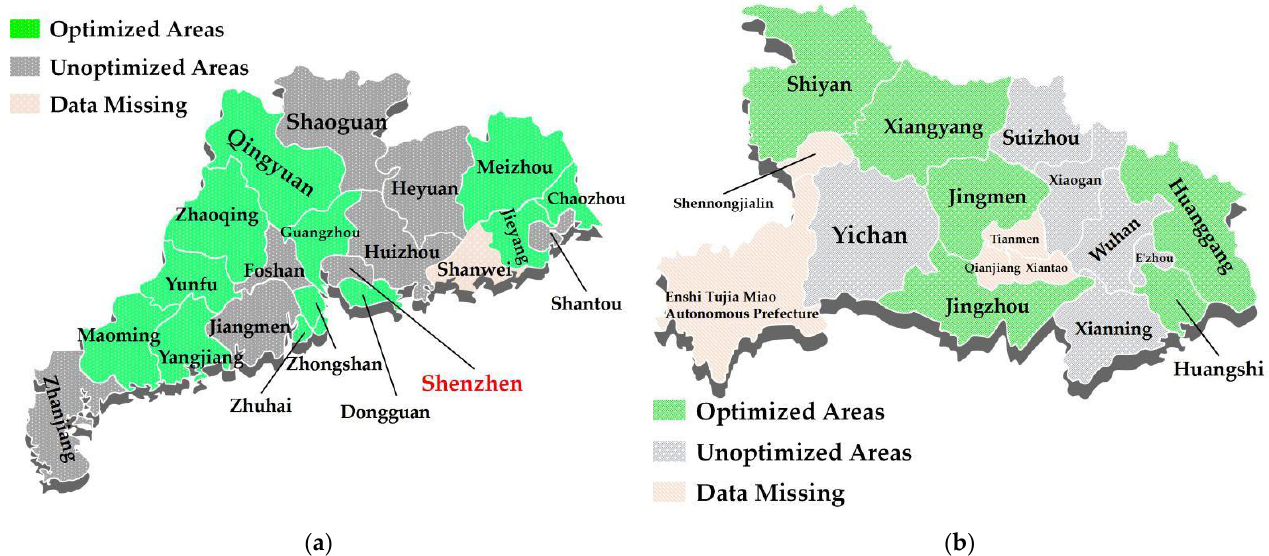
Figure 6. Spatio-temporal Evolution Pattern of LUE_Env. ( a ) Guangdong Province. ( b ) Hubei Province.